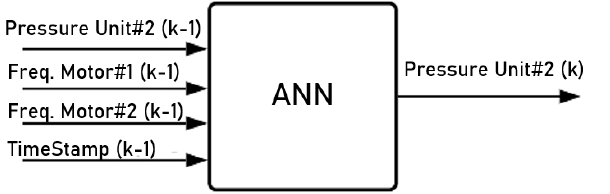
Figure 16. Input–output relationship of the ANN model. Source: author.